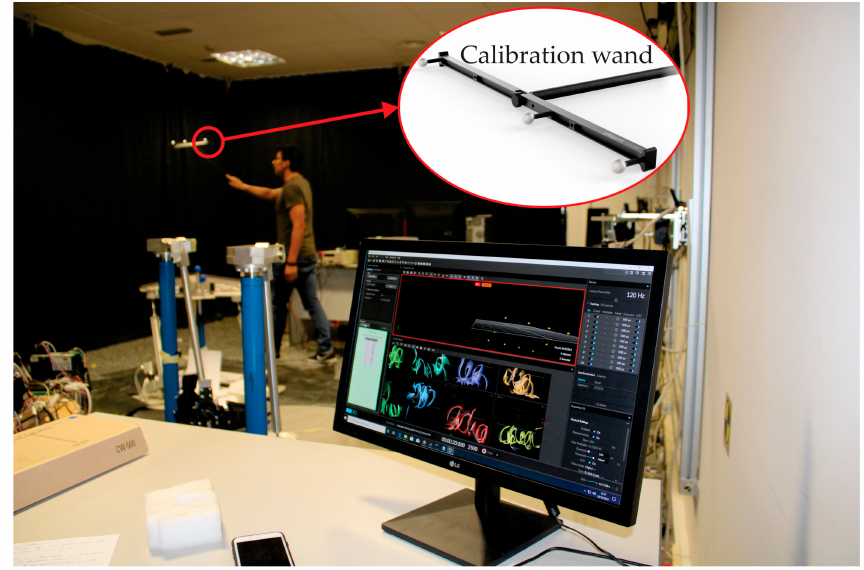
Figure 6. Calibration wand and experiment to determine the location of the markers.